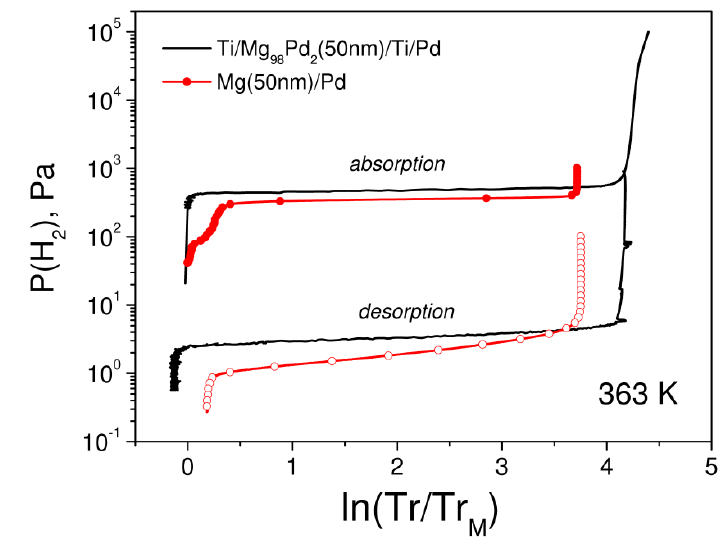
Figure 10. Pressure-transmission-isotherms of the co-sputtered Mg Mg/Pd film at 363